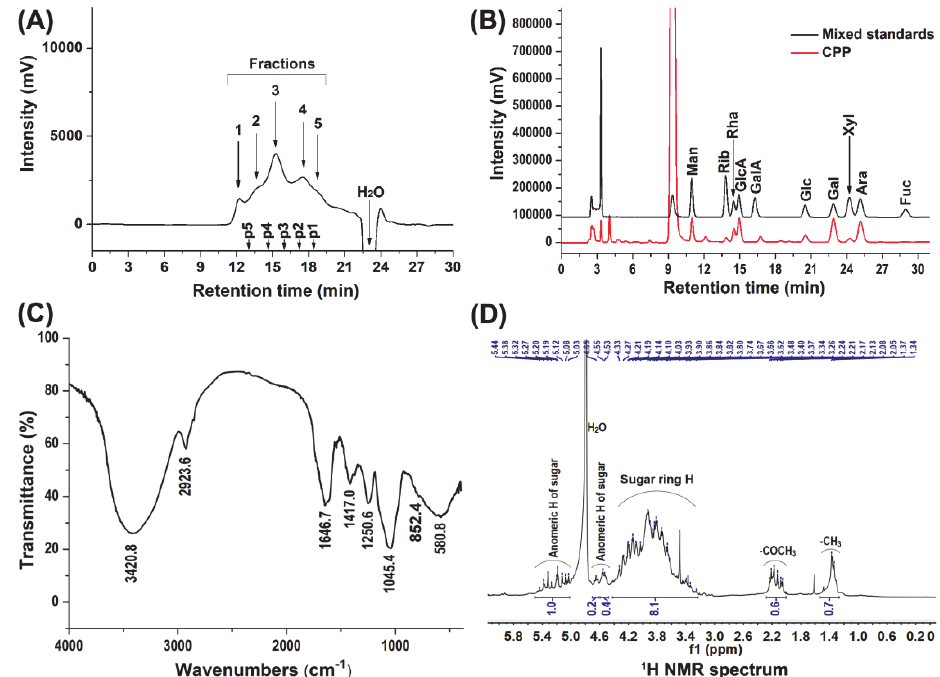
Figure 1. HPGPC profile ( A ), monosaccharide composition ( B ), FT-IR spectrum ( C ), and 1 H NMR spectrum ( D ) of CPP. The retention times of the pullulan standards p1–5 ( A ) were 18.3, 17.2, 16.0, 14.8, and 13.0 min, respectively.